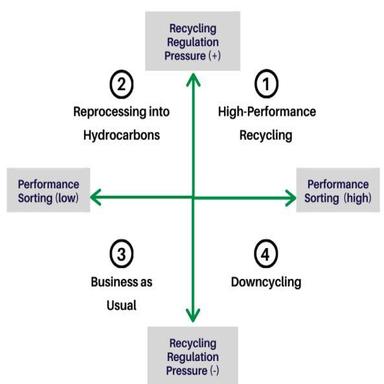
Scenario matrix for the future of MMPP recycling, considering sorting technologies performance and recycling regulation pressure on the axes (x/y). Scenario 1 represents the foreseen future when both factors are existent in a (+/+) scenario; scenario 2 shows the future for a (-/+) case, scenario 3 a (-/-) situation and scenario 4 a (+/-) situation.